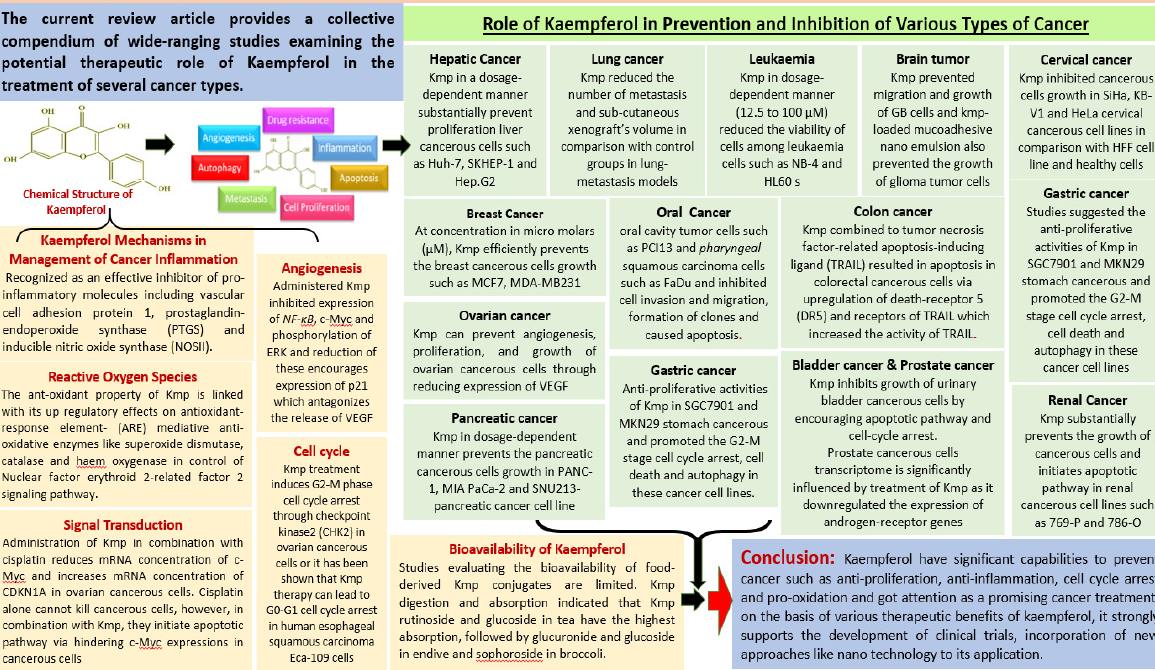
Figure 2. Graphical representation of literature